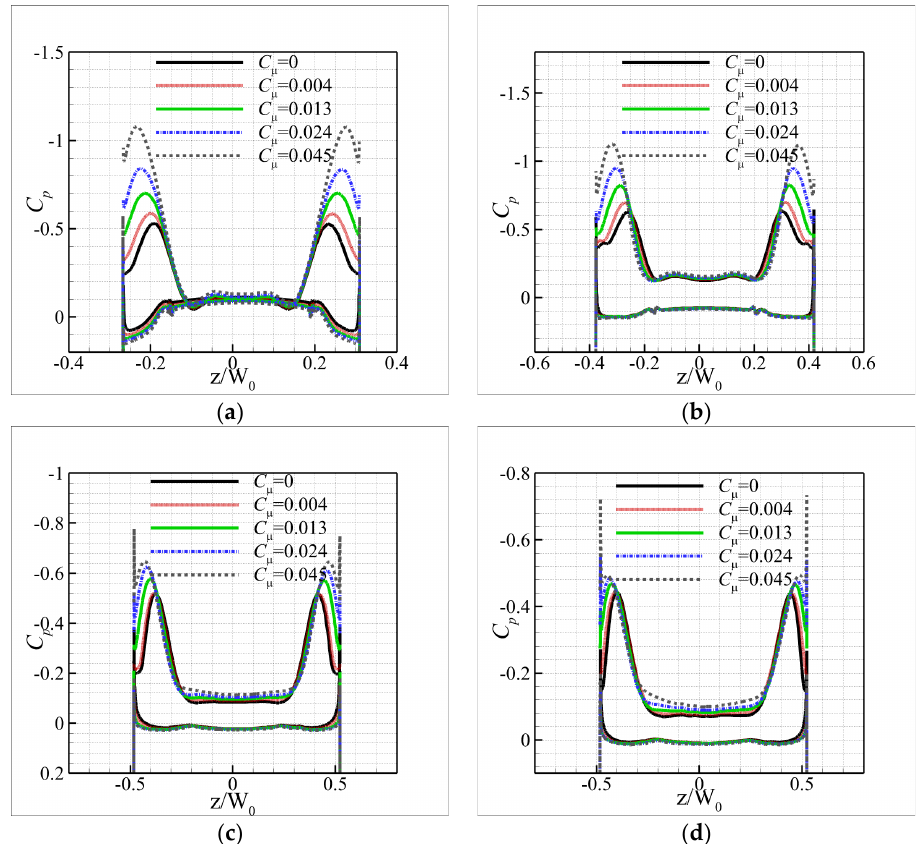
Figure 16. Comparison of the pressure coefficient distributions at the chosen cross-sections by the lateral jets with different jet momentum coefficients at α = 10 ◦ . ( a ) x / L 0 = 0.5; ( b ) x / L 0 = 0.6; ( c ) x / L 0 = 0.75; ( d ) x / L 0 =